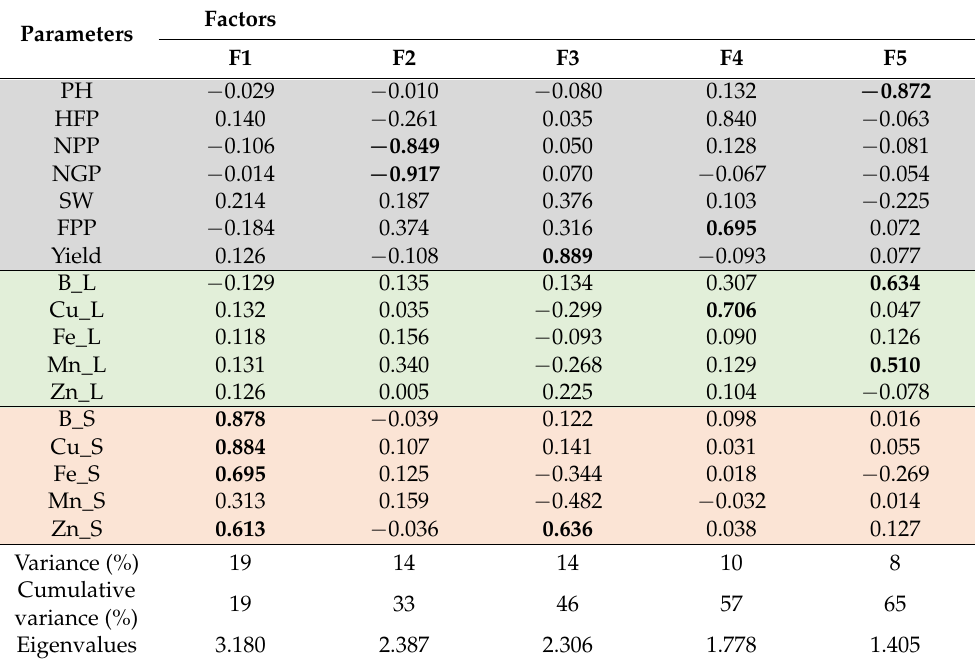
Table 5. Factor analysis (FA) was extracted through the principal factor analysis (PFA) and rotation method (bold loadings >